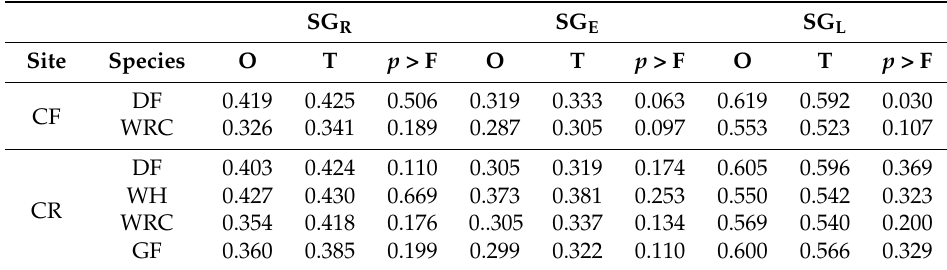
Table 5. Least Square Means for whole-core area-weighted wood specific gravity for Douglas-fir (DF), western hemlock (WH), western redcedar (WRC), and grand fir (GF) trees growing under contrasting vegetation management treatments on sites located in the Cascade foothills (CF) and the central Coast Range (CR) of western Oregon. SG R SG E SG L Site Species O T p > F